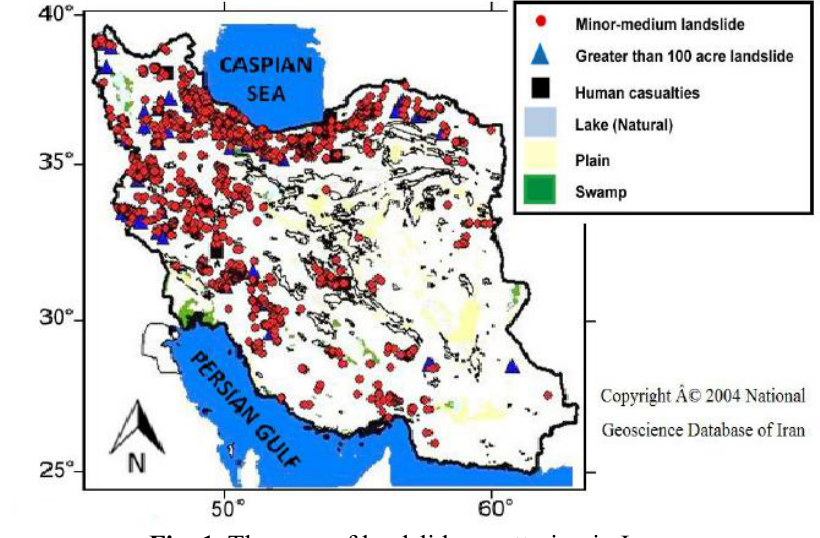
Fig. 1. The map of landslides scattering in